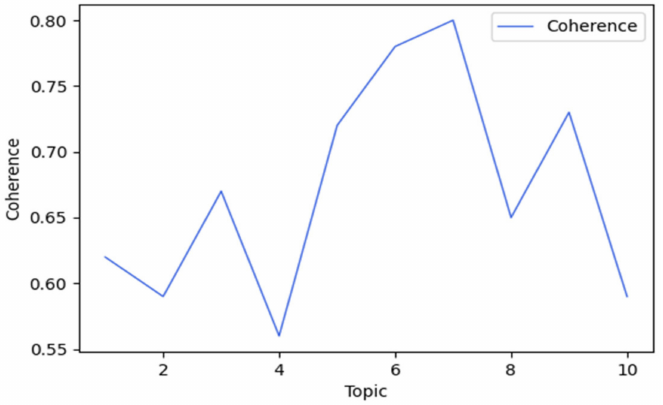
Figure 4. Topic coherence results.